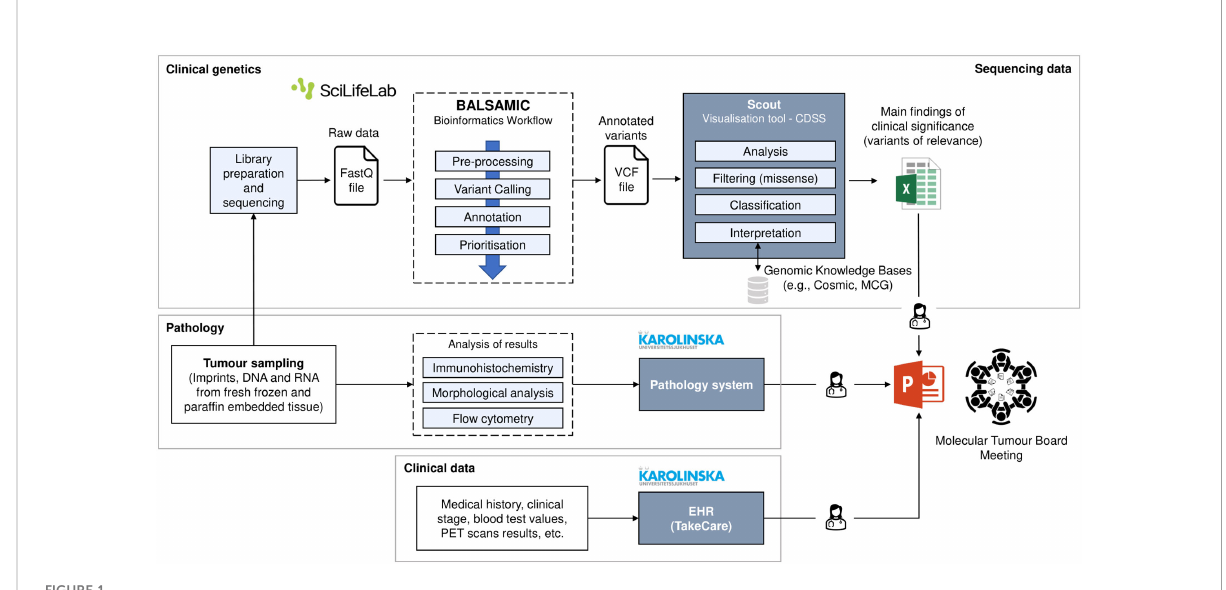
FIGURE 1 Current work fl ow for MTB meetings in the BioLymph